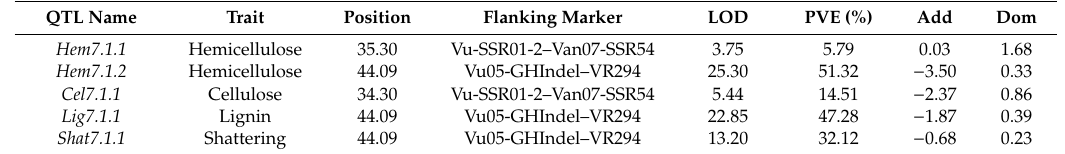
Table 1. Locations and e ff ects of QTLs identified for pod fiber contents and pod shattering in F 2:3